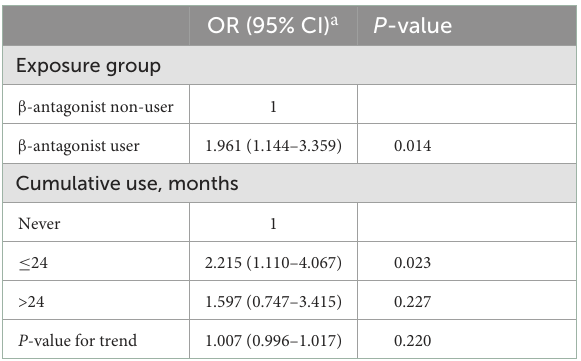
TABLE 4 Association between β -antagonist users and risk of